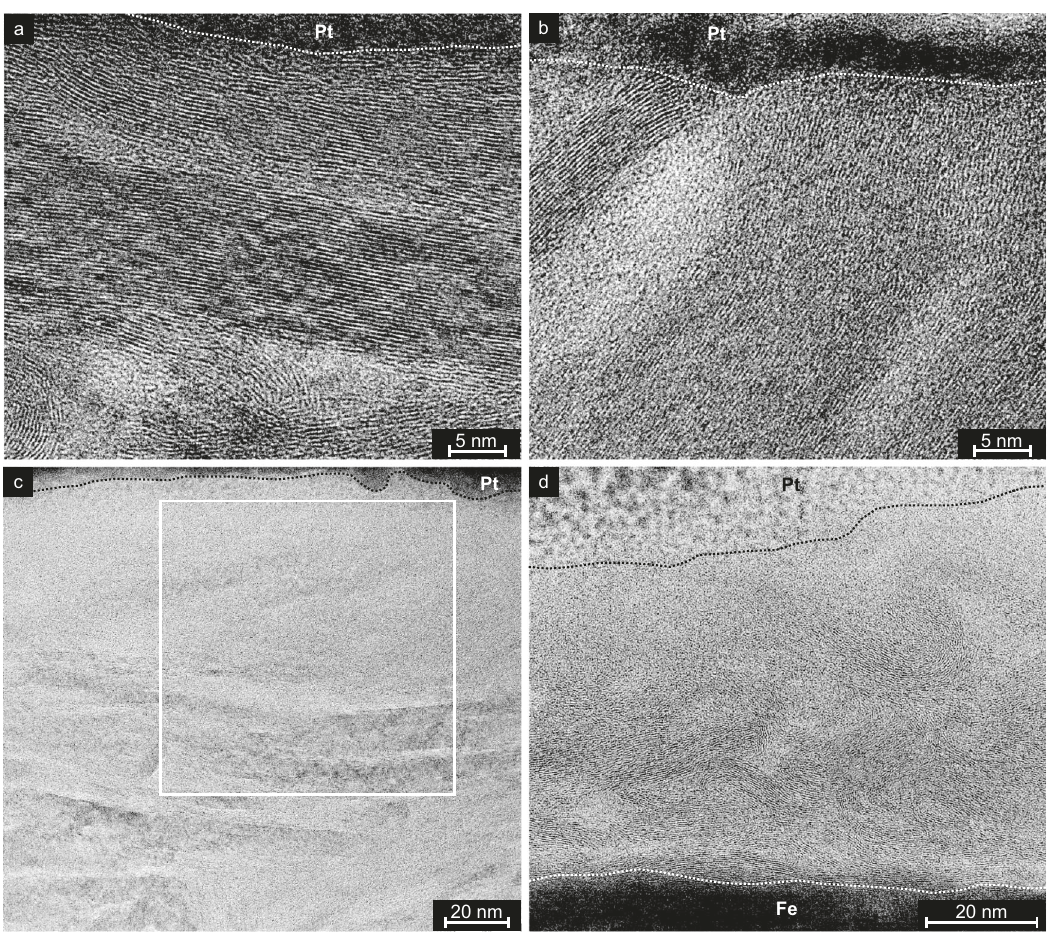
Fig. 5 | HR-TEMimagesofthe graphite layeratthe free surface coveredbya Pt layertoavoiddamagebyTEMpreparation. Imagestakenpriorto( a , b )andafter ( c , d ) the sliding experiments at c 50MPa and ≤ 5% RH; d 1GPa and 24% RH. For a